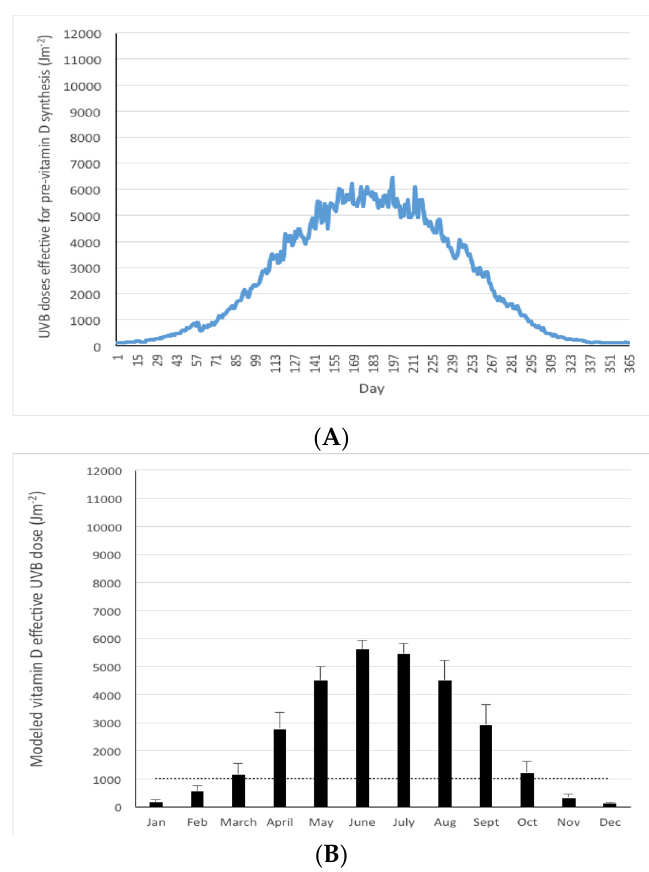
Figure 1. Mean modeled UVB doses effective for pre ‐ vitamin D 3 synthesis (Jm − 2 ) in Germany (47–55° N) on a daily ( A ) and monthly ( B ) basis in a typical year (mean of 2003–2012). Dotted line in panel B reflects a threshold of 1000 Jm − 2 as a guide to a dose below which dermal synthesis of pre ‐ vitamin D 3 is relatively low.